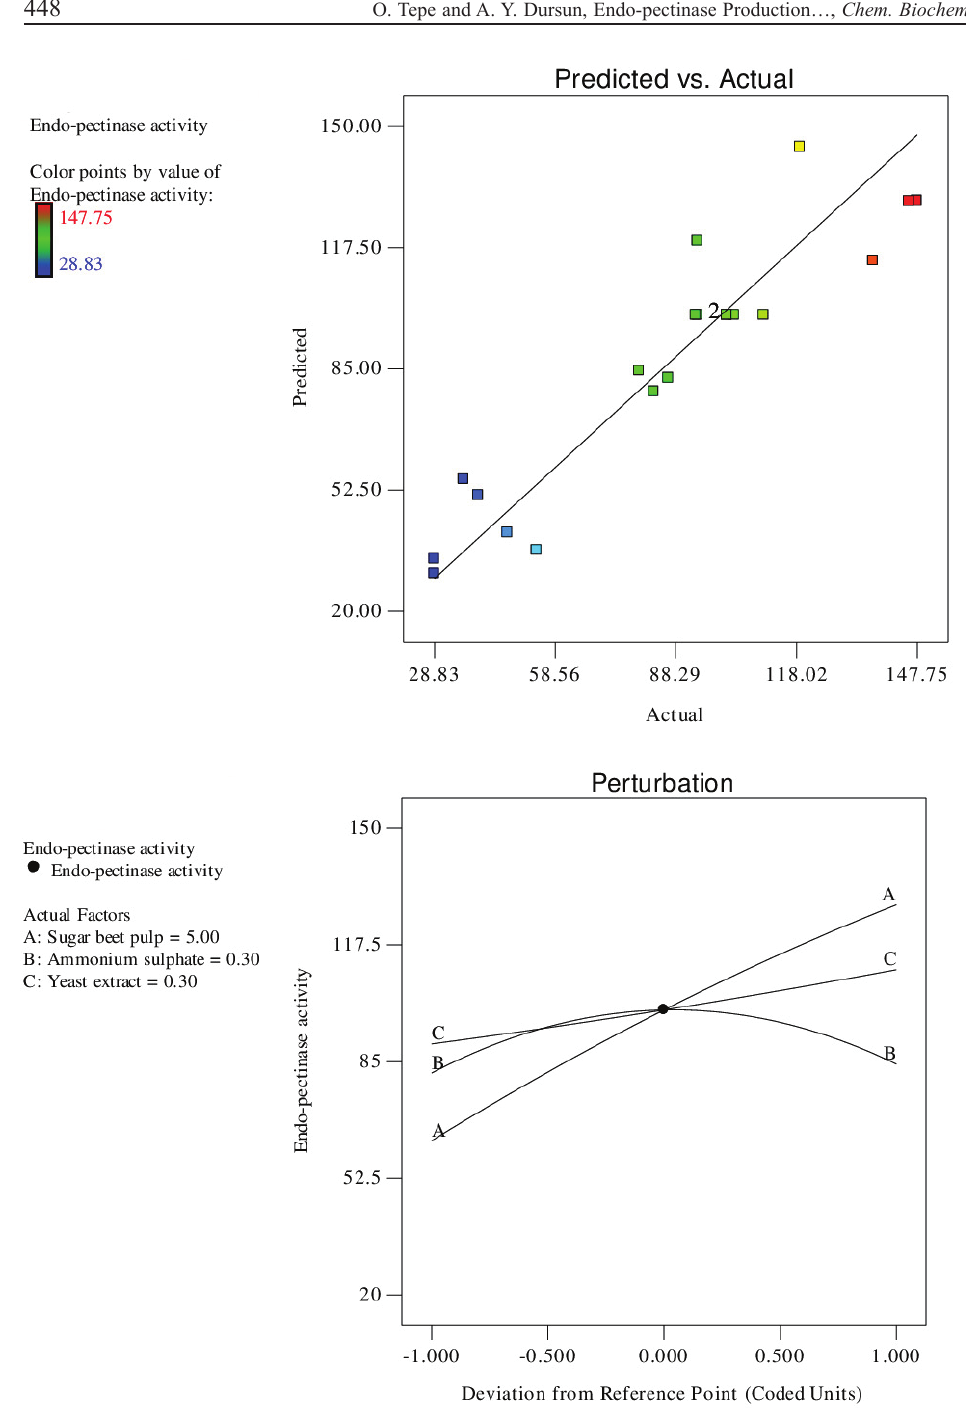
8(b) shows the changes of endo-pectinase activity with A, B, and C according to the reference point. Three-dimensional and contour curves showing the change in endo-pectinase activity according to concentrations of sugar beet pulp, (NH yeast extract are shown in Fig. 9. As seen in the contour (projection) graphs, the curves of the ob- tained response values are shown on a plane.